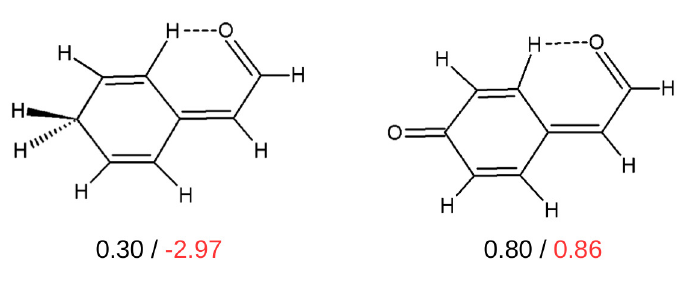
Figure 21. The values (in kcal/mol) of the interaction energies of the C-H · · · O contacts estimated by OCM (black values) and IRM (red values)